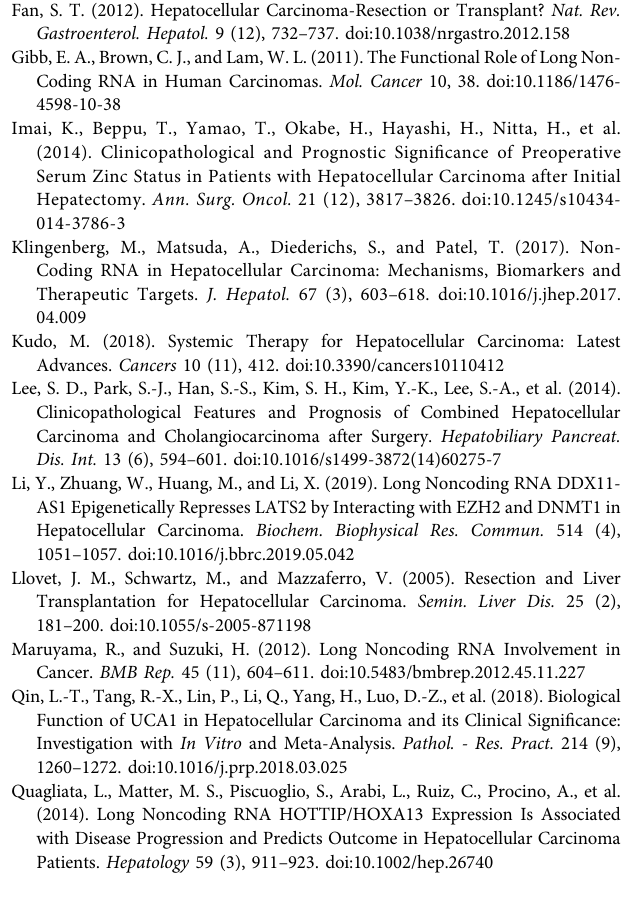
Supplementary Figure 1 | A prognostic model for OS and RFS of HCC patients from our center. (A) Risk score distribution, TMCO1-AS1 expression, and OS and RFS of patients in the high- and low-risk group. (B) Comparison of the distributions ofpatientswithdifferentcharacteristicsinthehigh-and low-riskgroups. (C) Kaplan- Meier OScurves forpatientsinthehigh- and low-risk groups. (D) Kaplan-Meier RFS curves for patients in the high- and low-risk